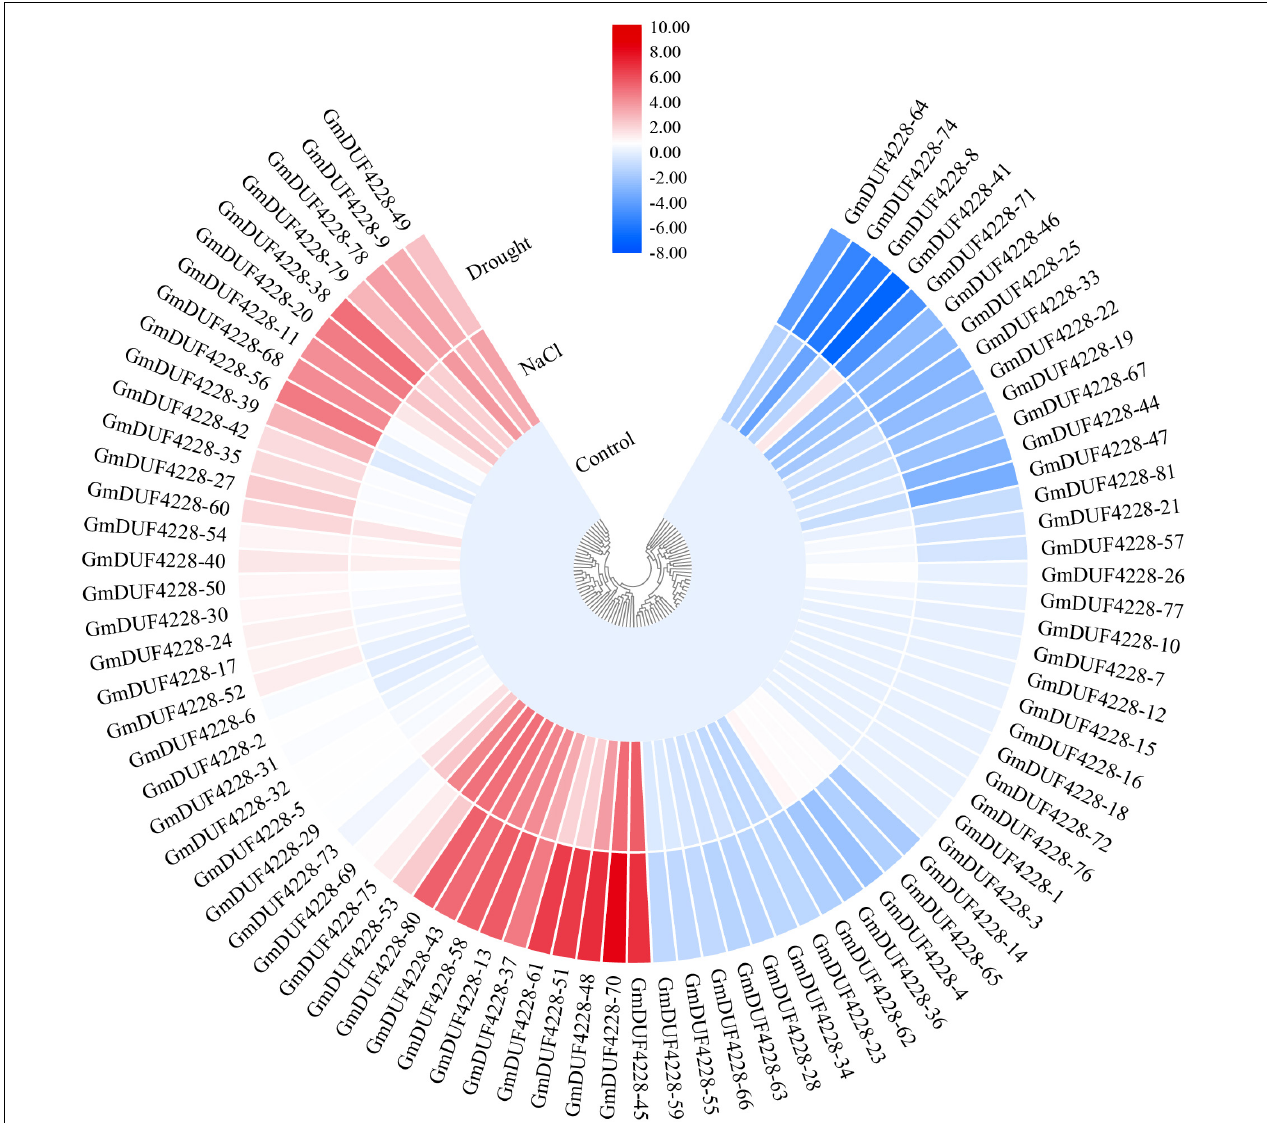
FIGURE 5 | Heatmap based on hierarchical cluster analysis of 81 GmDUF4228 gene expression profiles under drought and salt stresses and control conditions. Red and blue represent high and low expressions, respectively.